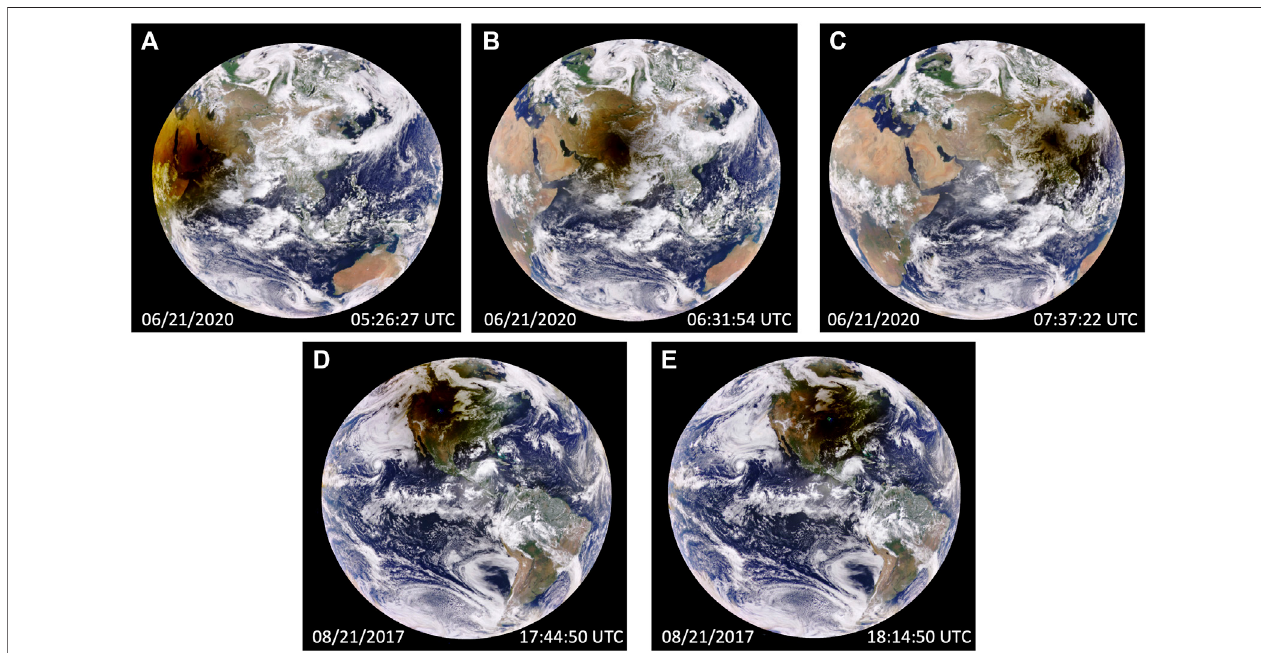
FIGURE 1 | Three EPIC images taken during 21 June 2020 solar eclipse when the center of the Moon ’ s shadow was in (A) Arabian Peninsula, (B) Himalayas, and (C) Southwest China. TwoEPIC images taken during 21 August 2017 when the center ofthe Moon ’ s shadow wasin (D) Casper,Wyomingand (E) Columbia, Missouri.